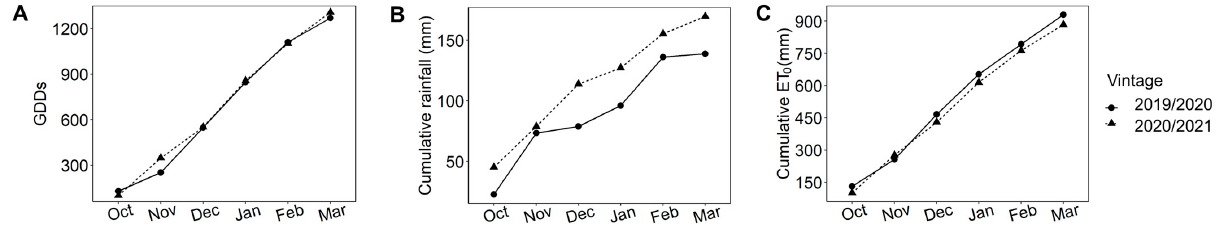
Figure 3. Cumulative growing season data showing ( A ) growing degree days (GDDs), ( B ) rainfall, and ( C ) evapotranspiration (ET 0 ) during the 2019/2020 and 2020/2021